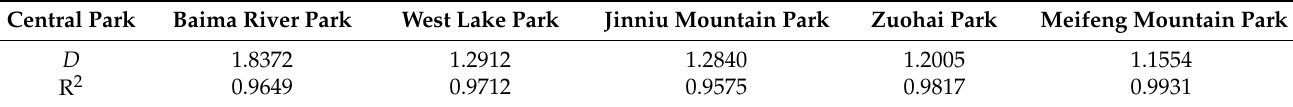
Table 1. The determining data of fractal dimension of Fuzhou’s park